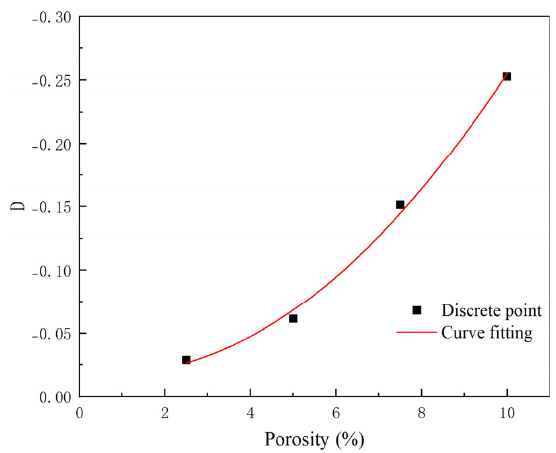
Figure 14. Fitting curve for parameter D vs. porosity.